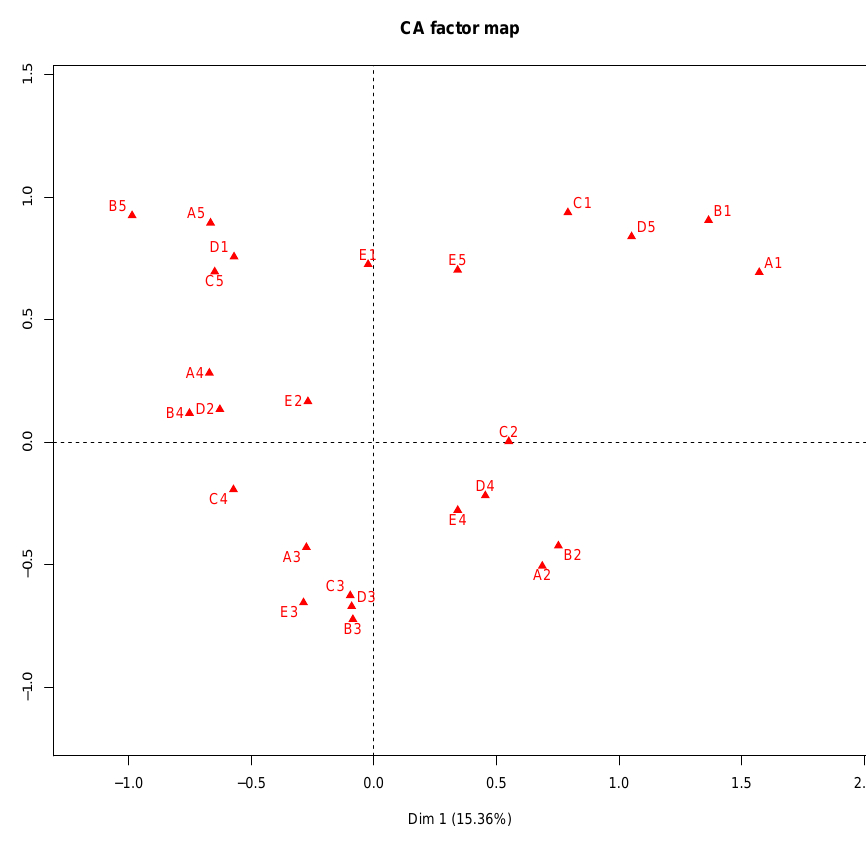
Figure 2: Correspondence Analysis symmetric map (1st and 2nd